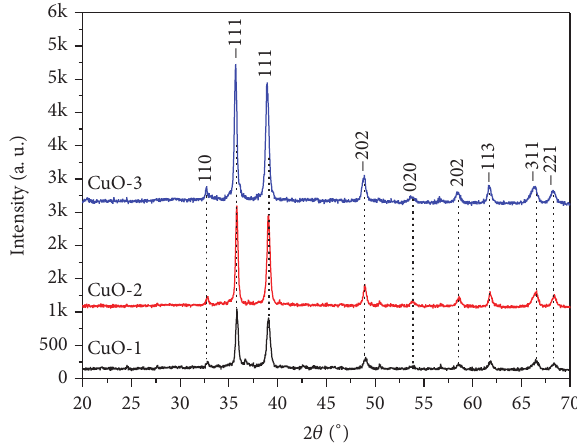
Figure 1: XRD diffractograms of CuO NPs synthesized using extracts of wastes of Cauliflower (CuO-1) and Potato (CuO-2) and Peas (CuO-3)